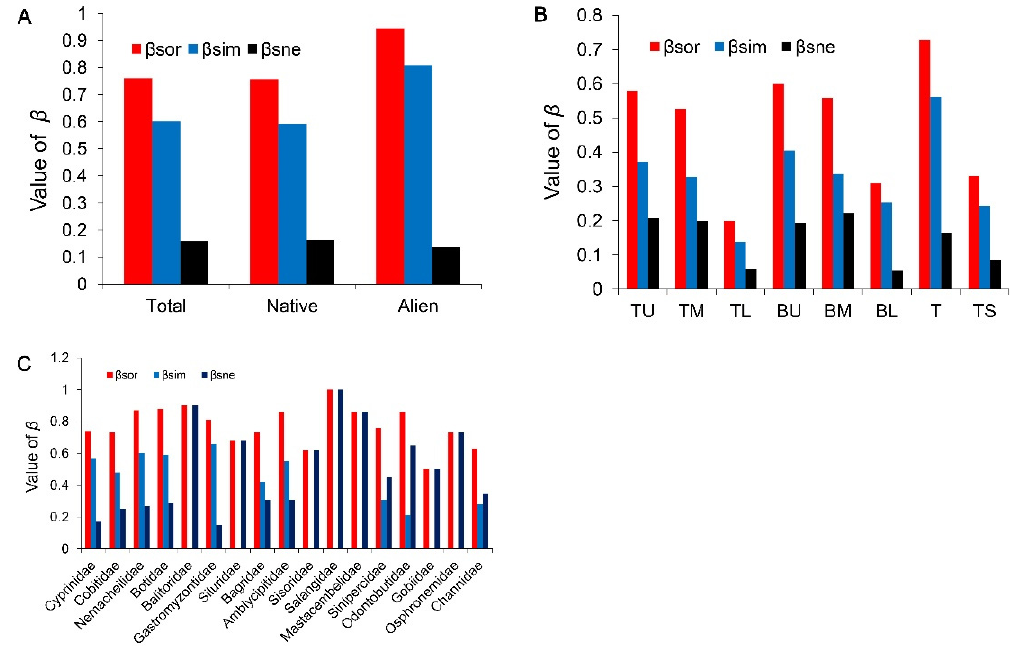
Figure 4. Beta diversity according to origin ( A ), basins of the Gan River Basin ( B ), and families ( C ) quantified by the Sørensen index ( β sor ) and its species spatial turnover ( β sim ) and nestedness components ( β sne ) in the current period. River codes are the same as in Table 1.